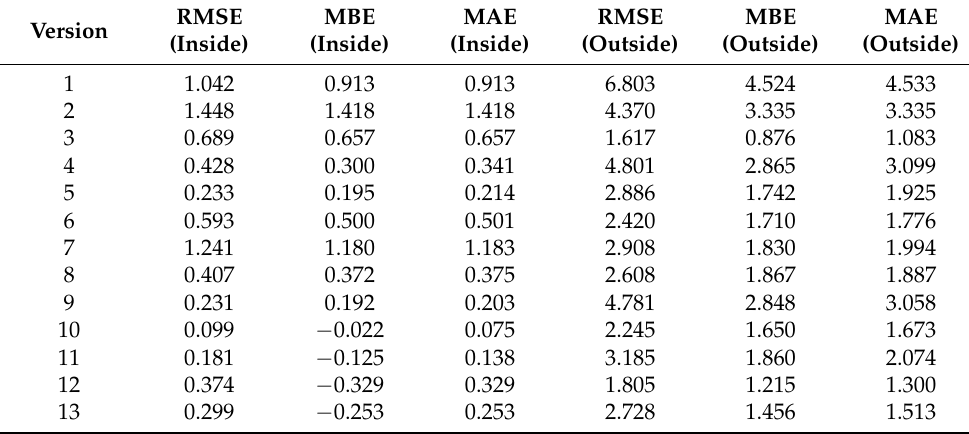
Table A7. Root mean square error (RMSE), mean bias error (MBE), and mean absolute error (MAE) for the calibrated values of the air temperature (K) in the enclosures in a Stevenson Screen (inside) and next to a Stevenson Screen (outside) exposed to direct